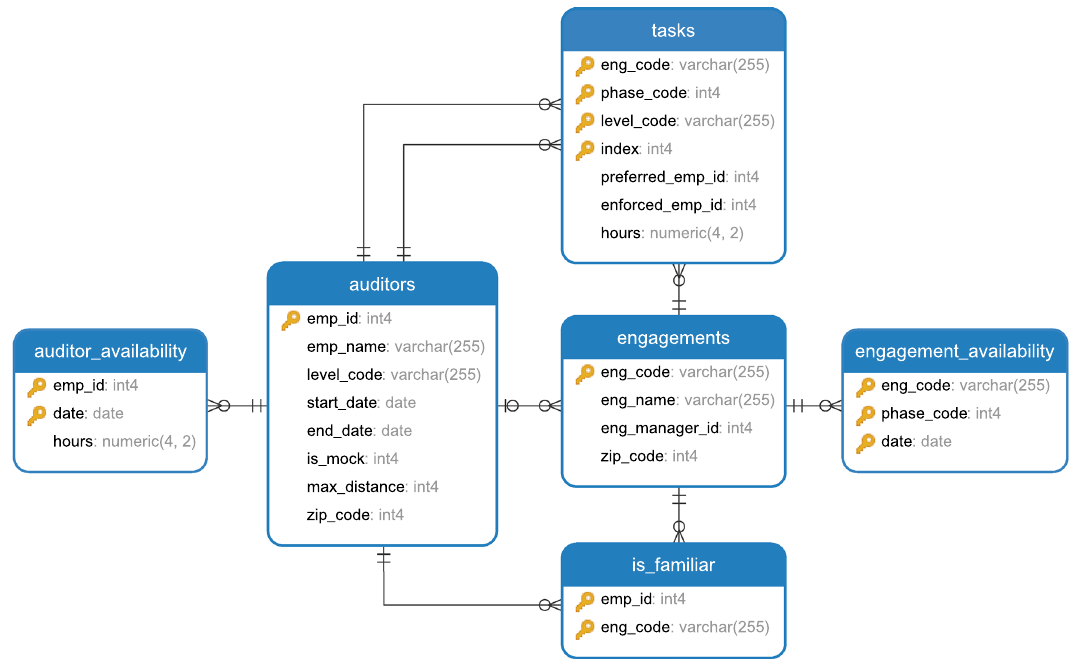
Fig. 6 Entity-relationship diagram of the input data in IE notation